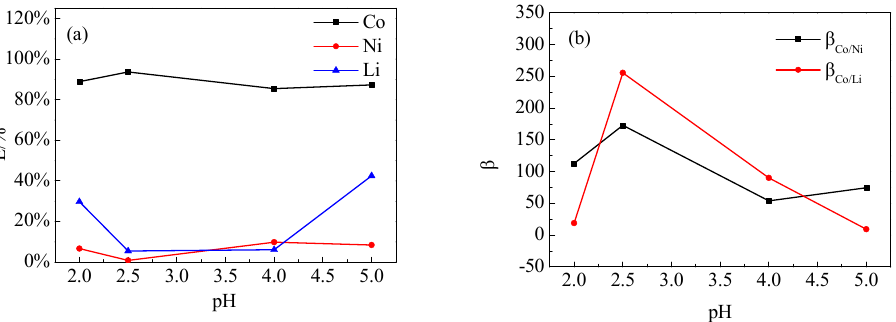
Figure 9. Effect of pH on ( a ) extraction efficiency and ( b ) separation coefficient (V P507–N235 : V kerosene = 1:3, V P507 :V N235 = 3:7, V o :V a = 3:1).